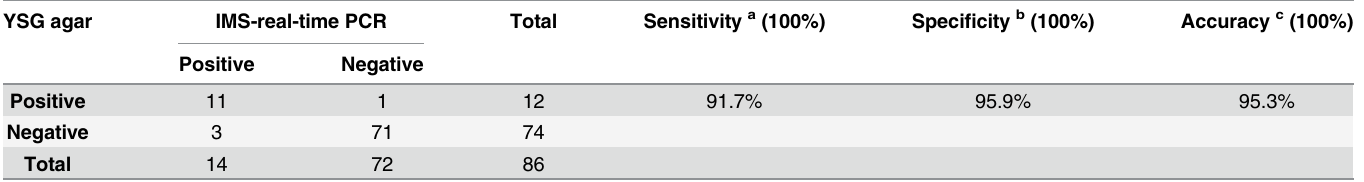
Table 3. Comparison of the IMS-real-time PCR and the standardized pour plate method in naturally contaminated kiwi fruit juice products detection. YSG